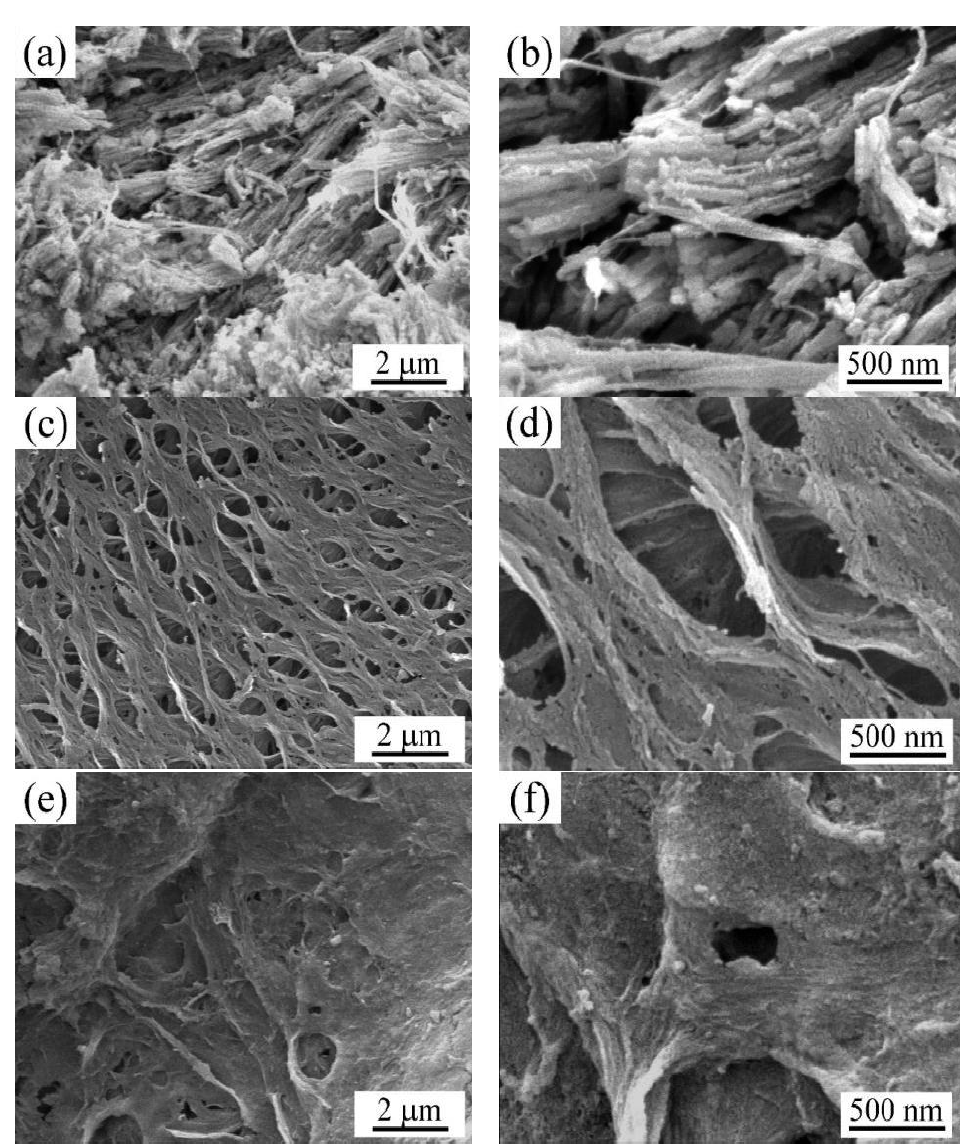
Figure 2. SEM images of ( a , b ) crab shell powder; ( c , d ) crab shell biochar (CSB); ( e , f ) crab shell biochar modified by potassium hydroxide activated biochar modified by potassium hydroxide (CSAB).